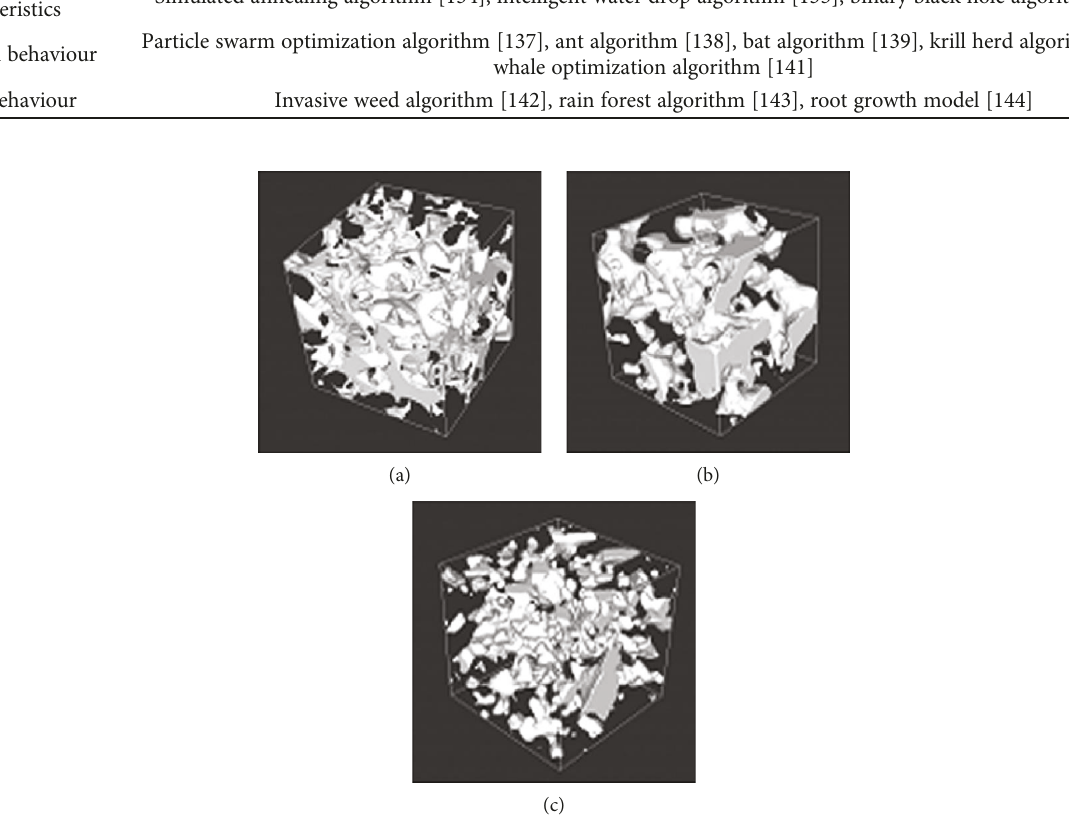
Figure 7: Particle swarm optimization (a), Fourier transform-based Gaussian fi eld method (b), and simulated annealing method (c) reconstruction results of 3D digital core. Among them, the 3D digital core with the same background color is the skeleton, and the white part is the pores. It can be observed that the reconstruction e ff ect of particle swarm optimization is better than that of the simulated annealing algorithm, and the obtained 3D digital core has better connectivity in the pore space. Figure from